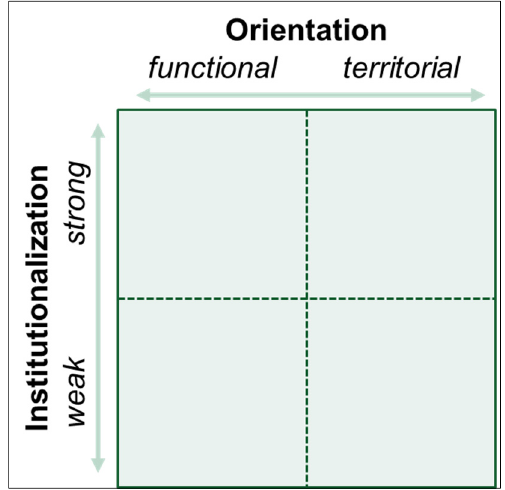
Figure 1. The heuristic matrix for capturing organization variation in cross-border governance systems. Source: Authors’ own